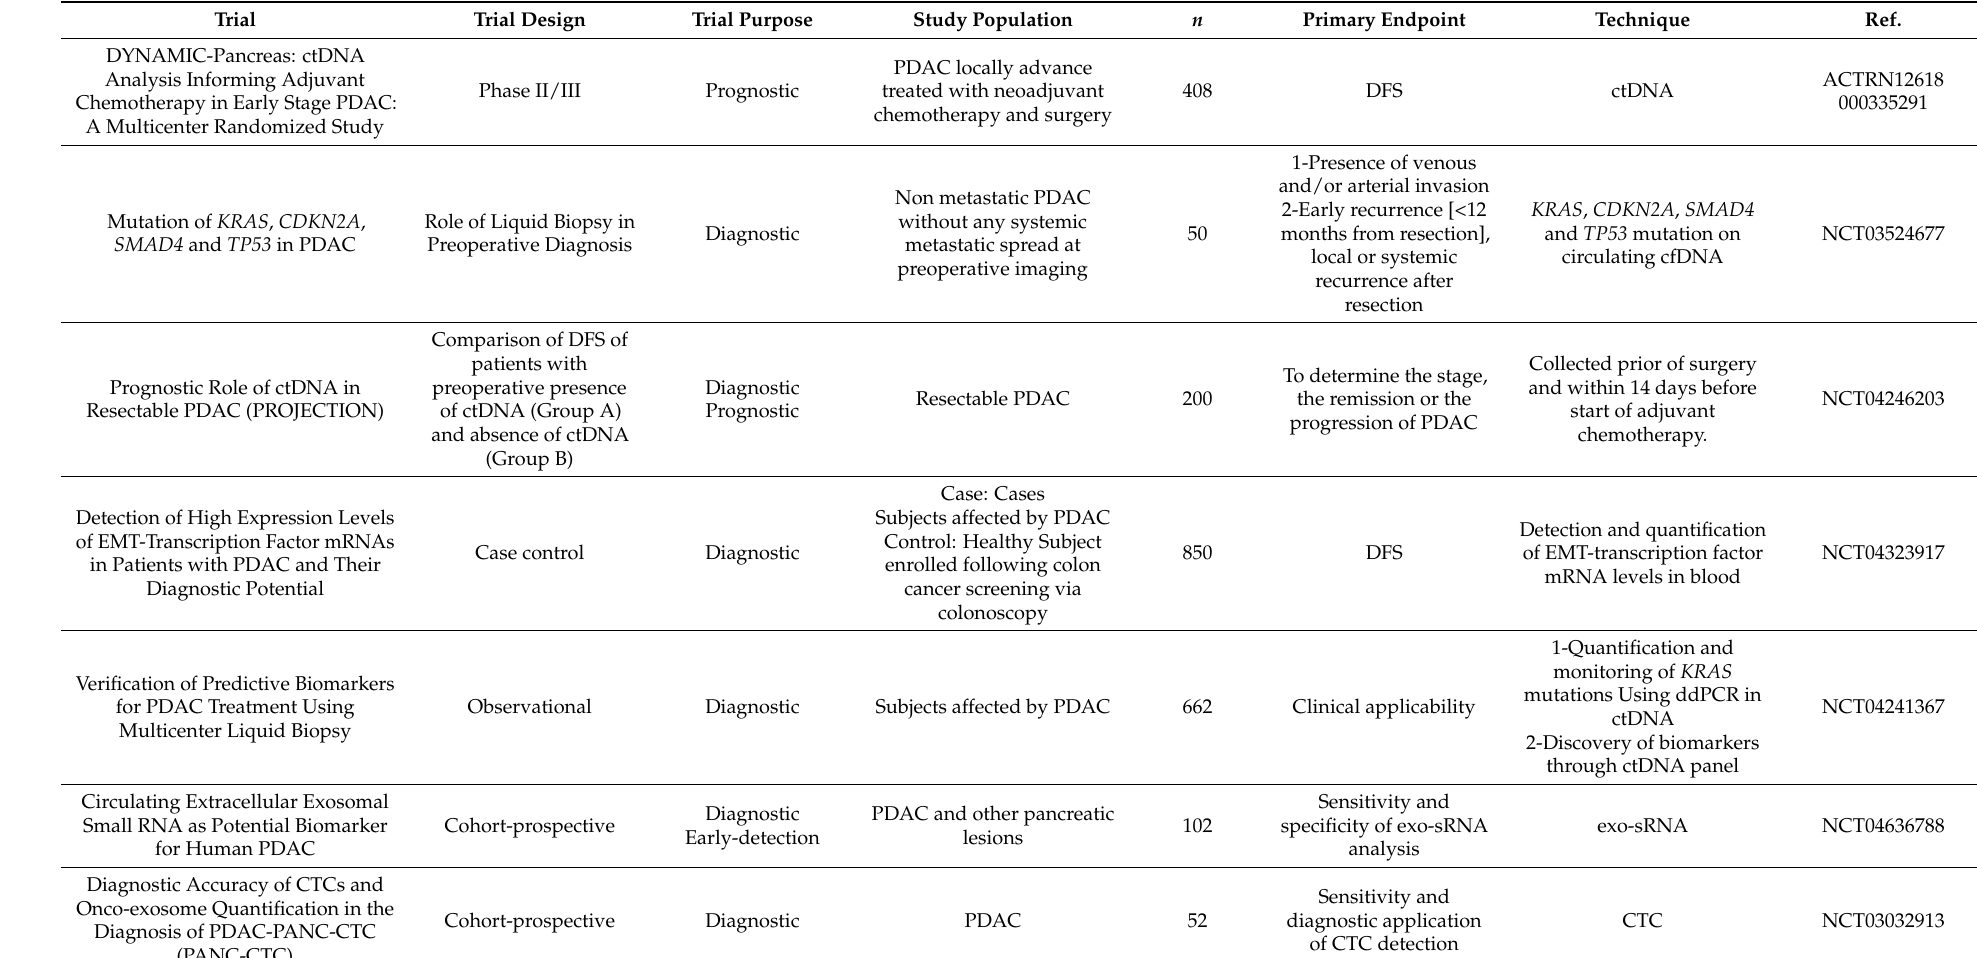
Table 3. Liquid biopsy in pancreatic cancer ongoing clinical